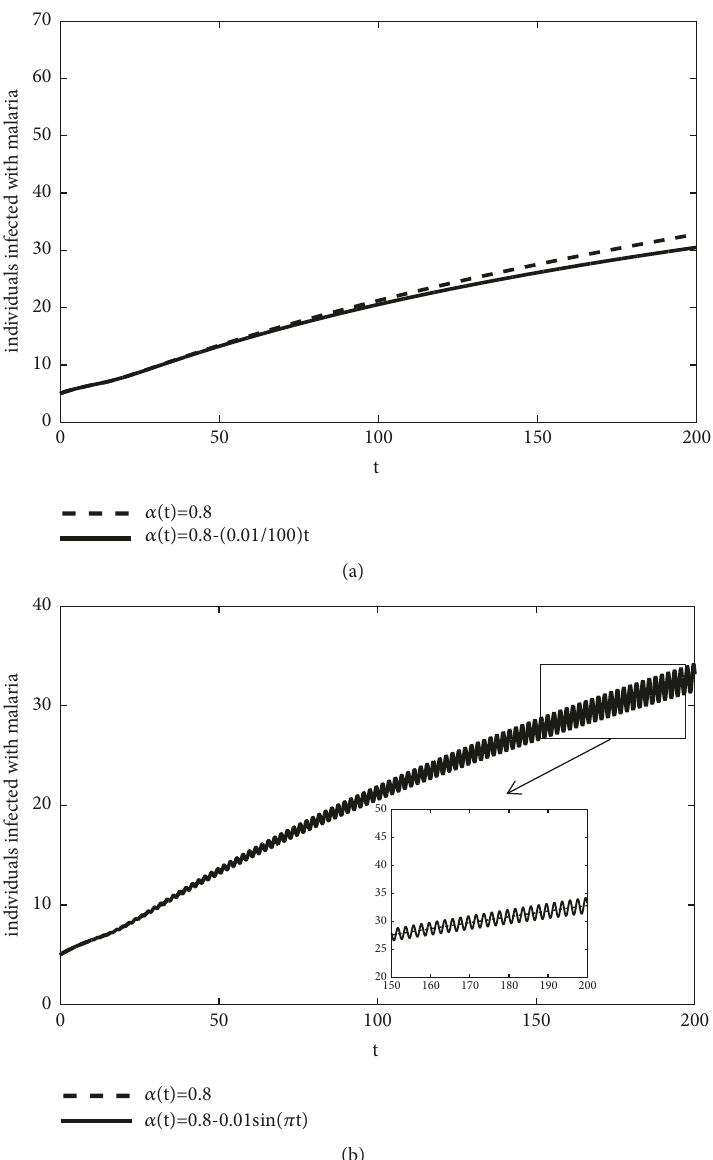
Figure 6: Individuals infected with malaria with 𝜓 = 3 . Parameters values are in Table 1 with 𝛽 ℎ = 0.05 . (a) 𝛼(𝑡) = 0.8 comparing with 𝛼(𝑡) = 0.8 − (0.01/100)𝑡 ; (b) 𝛼(𝑡) = 0.8 comparing with 𝛼(𝑡) = 0.8 − 0.01 sin (𝜋𝑡)